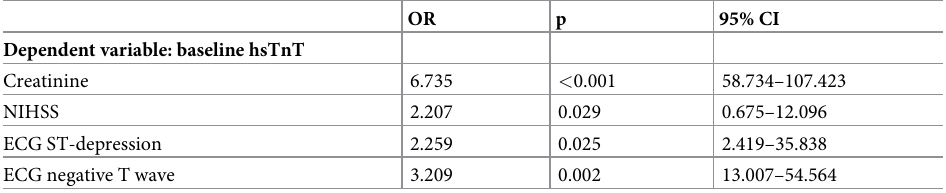
Table 2. Independent predictors of baseline hsTnT